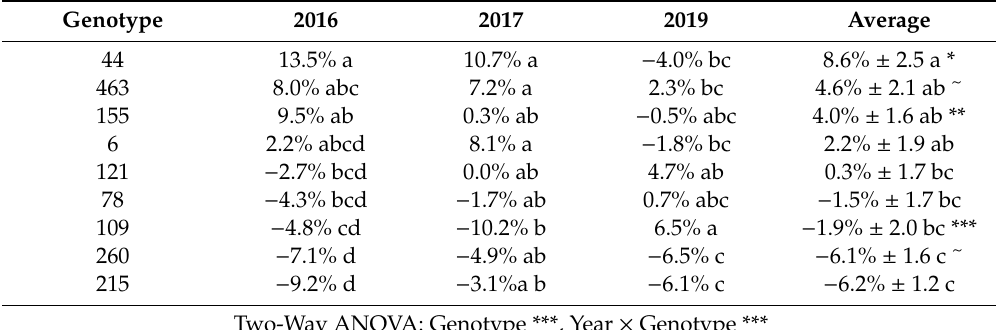
Table 6. Variation in percentage respect to predicted value per genotype and year in Roda field.